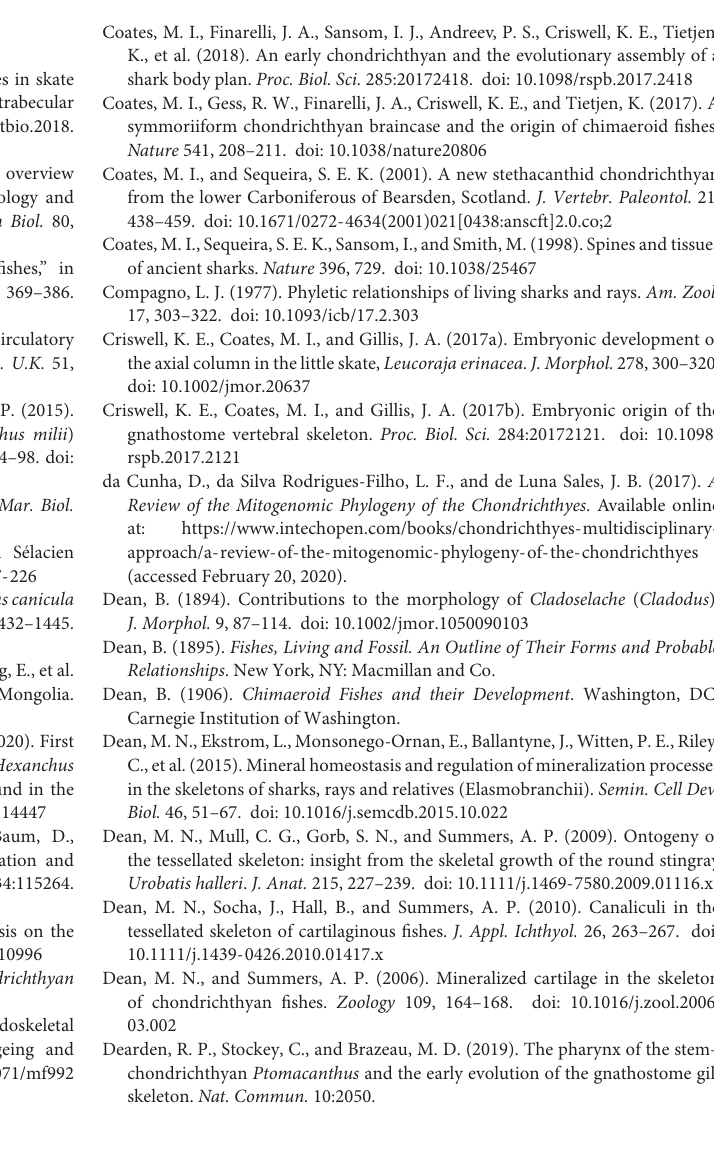
Supplementary Figure 1 | SEM images of mineralization from the synarcual (anterior fused vertebrae) of the second adult Callorhinchus milii (Holocephali; Callorhinchidae). (A) Tesselated mineralization from a planar perspective; (B) close up of mineralization from a planar perspective. Supplementary Table 1 | Holocephali tesserae size